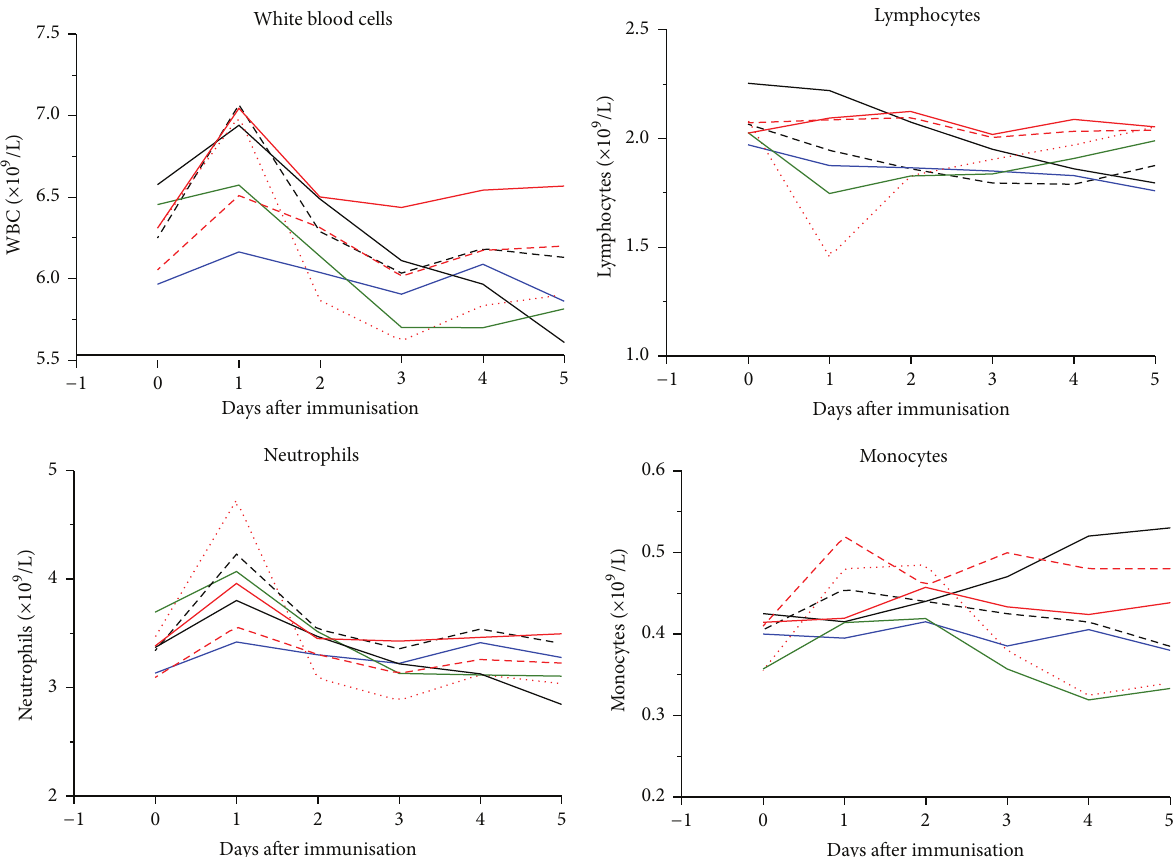
with adjuvanted (red), unadjuvanted (green), or live (black) vaccines, or saline placebo.